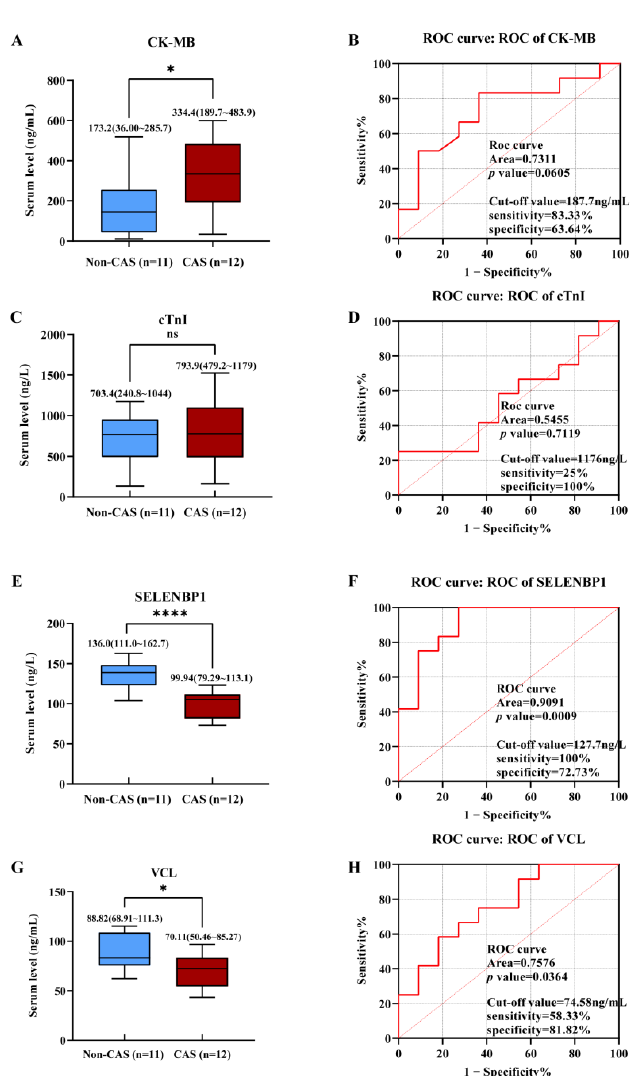
Figure 6. Serum SELENBP1 or VCL alone could be biomarkers for forensic diagnosis of CAS-induced sudden death. ( A ) Serum CK-MB levels in non-cardiac death (non-CAS) and CAS-induced sudden deaths. ( B ) ROC analysis of serum CK-MB for the diagnosis of CAS-induced sudden death. ( C ) Serum cTnI levels in non-cardiac death (non-CAS) and CAS-induced sudden deaths. ( D ) ROC analysis of serum cTnI for the diagnosis of CAS-induced sudden death. ( E ) Serum SELENBP1 levels in non-cardiac death (non-CAS) and CAS-induced sudden deaths. ( F ) ROC analysis of serum SELENBP1 for the diagnosis of CAS-induced sudden death. ( G ) Serum VCL levels in non-cardiac death (non-CAS) and CAS-induced sudden deaths. ( H ) ROC analysis of serum VCL for the diagno- sis of CAS-induced sudden death. ns — no significant. *, p < 0.05; ****, p < 0.0001 as indicated. Of note, the mean values of serum SELENBP1 and VCL for the forensic death cases were both lower than those in living patients, an observation that reinforced the negative association between serum SELENBP1 or VCL levels and CAS severity. In fact, binary logistic regression analysis showed that the risk of CAS-induced deaths decreased by